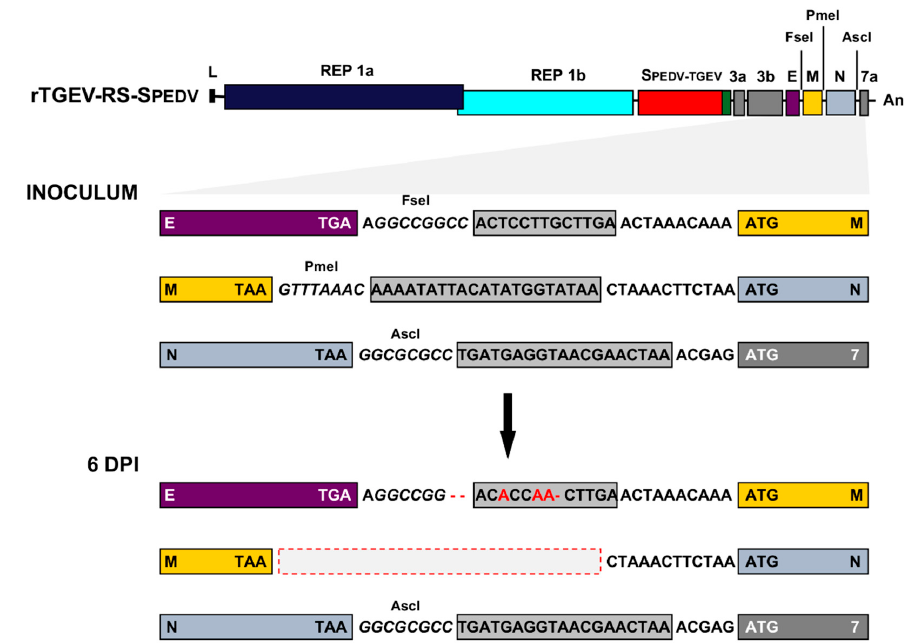
Figure 5. Genetic stability of rTGEV-RS-S PEDV vaccine candidate. Five-day-old piglets were orally inoculated with 10 6 TCID 50 / piglet. Jejunum samples were taken at 2, 4, and 6 days post-infection. RNA from these samples was extracted, virus was detected by RT-PCR, and the detected bands were sequenced. The modifications introduced in the recombinant virus used to inoculate the piglets (inoculum) were represented as in Figure 1C. The sequence changes observed at day 6 post-infection are represented in red: Dashes indicate nucleotide deletions, red nucleotides represent point mutations, and dashed box indicates large nucleotide deletion.